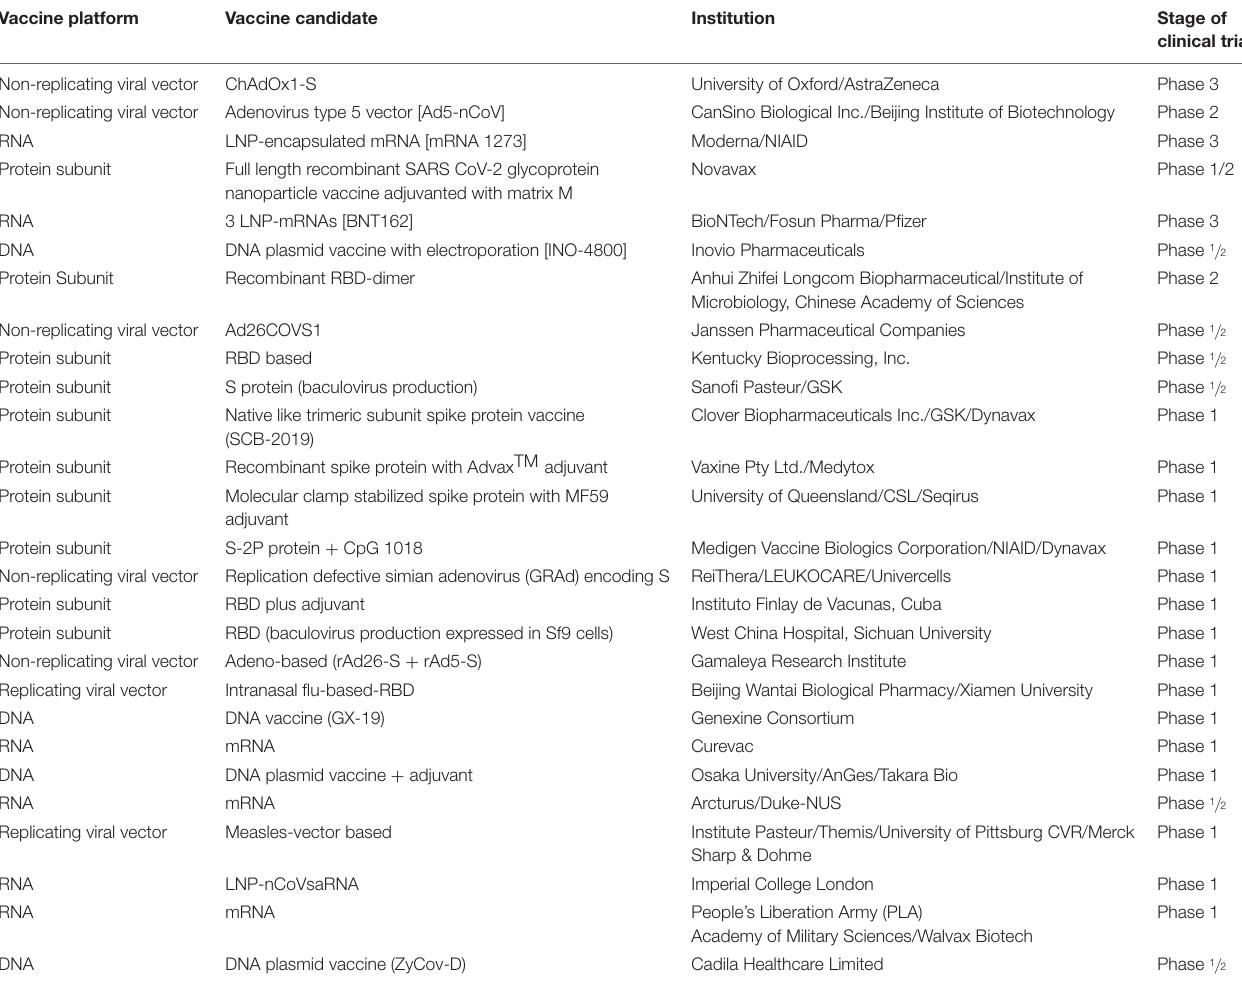
TABLE 4 | COVID-19 candidate vaccines based on spike protein and its functional domains. Vaccine